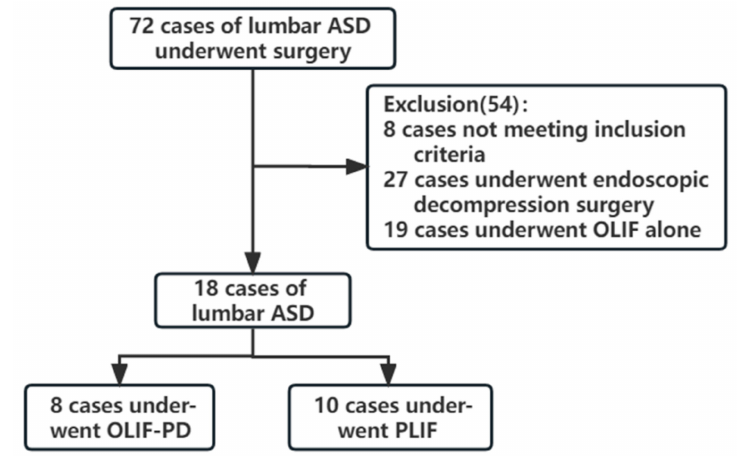
Figure 1. Flowchart of the experimental procedure.